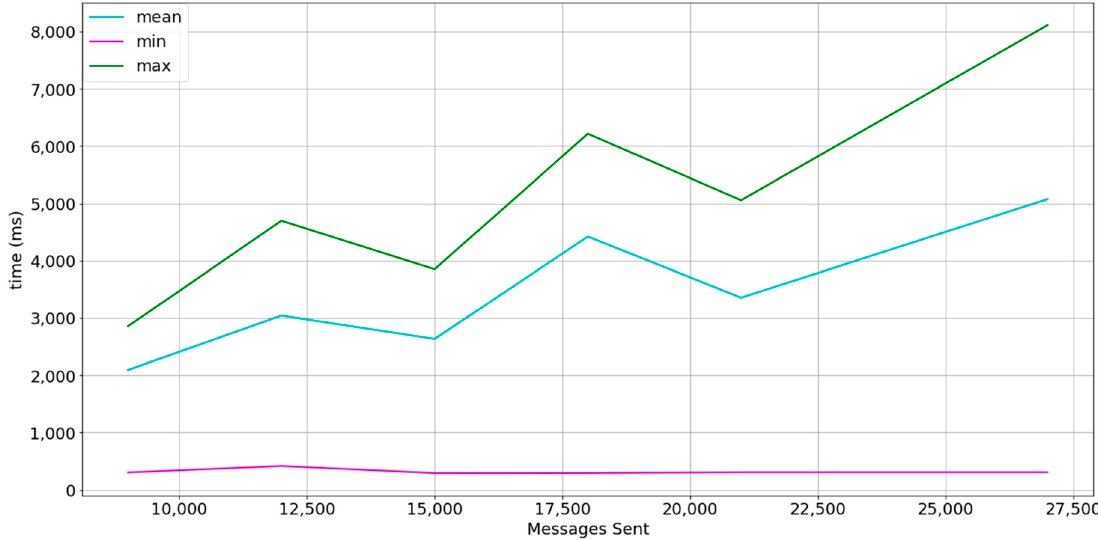
Figure 8. Results in experiment description setting 1 at a 1-s interval between bursts. The line in cyan represents the mean timedelta, the line in magenta represents the minimum timedelta, and the line in green represents the maximum timedelta.